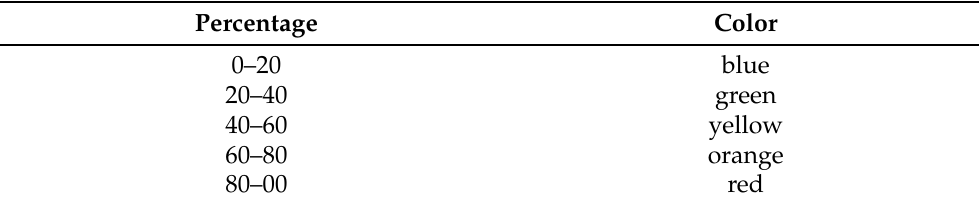
Table 2. Color bars for percentage ranges of bottleneck likelihoods.